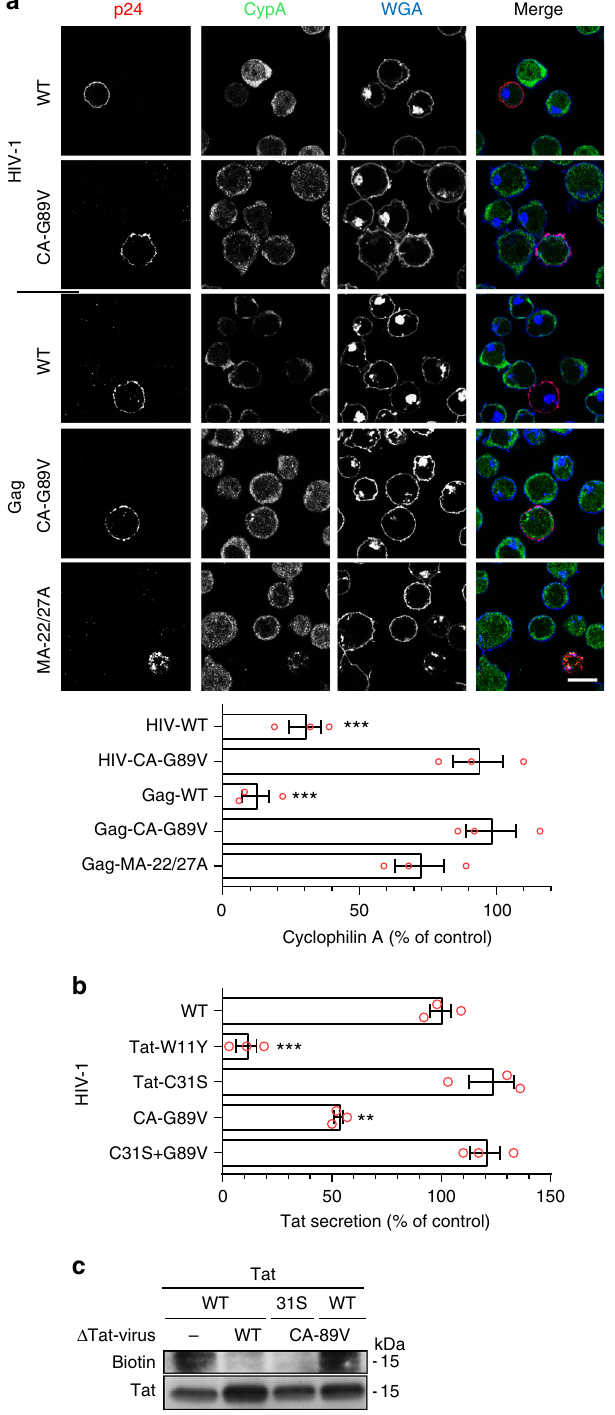
Fig. 9 Encapsidation-mediated depletion of cyclophilin A by HIV-1 inhibits Tat palmitoylation and enables strong Tat secretion. a Jurkat T-cells were infected with pseudotyped HIV-1 (NL4.3 WT or CA-G89V) or transfected with the indicated Gag mutant. After 24 h, cells were fi xed for CypA and p24 staining by immuno fl uorescence. WGA was used to label the plasma membrane and the TGN. Representative median optical sections are shown (bar, 10 µ m) together with the quanti fi cation from 20 < n < 30 cells. Representative results of n = 3 experiments. b Primary human CD4 + T- cells were infected with a pseudotyped NL4.3 bearing either a mutation in Tat (TatW11Y, unable to bind PI(4,5)P 2 or Tat-C31S, non-palmitoylable)